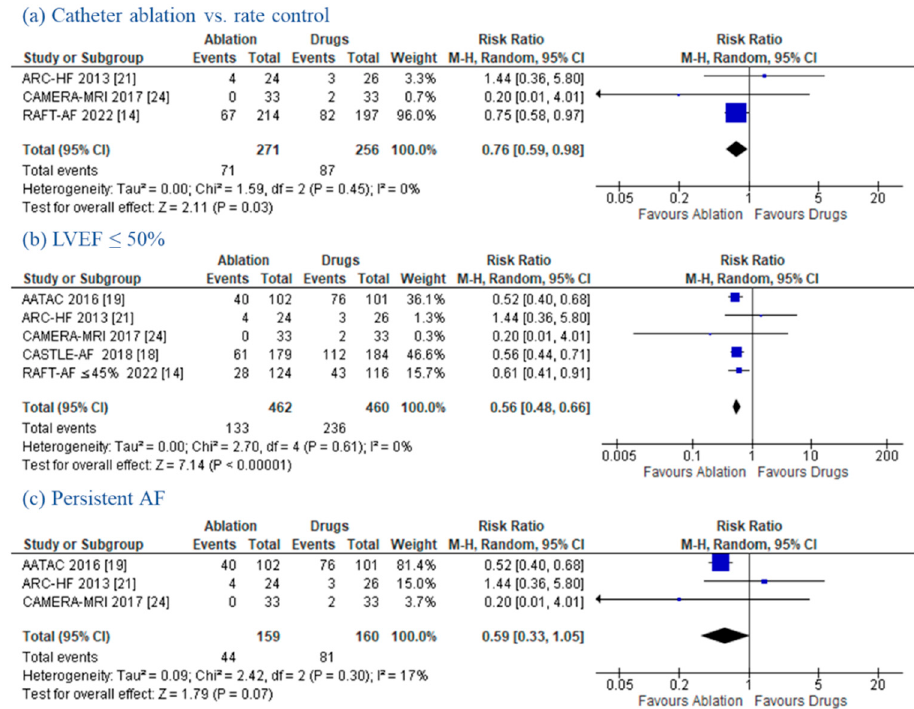
Figure 6. Sensitivity Analysis for the Composite Endpoint. Forest plots displaying a decrease in the composite endpoint in the sensitivity analysis: ( a ) catheter ablation vs. rate control, ( b ) LVEF ≤ 50%, ( c ) persistent AF. CI: confidence interval; HF: heart failure.